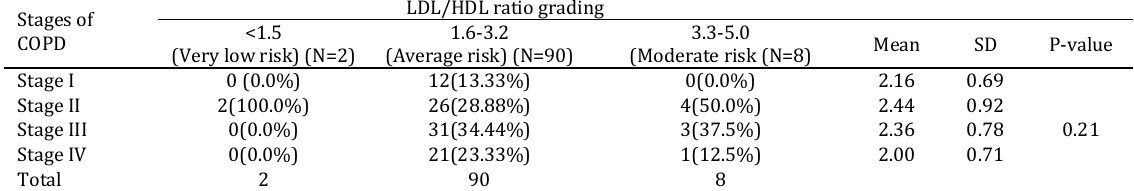
Table 6. Low-density lipoproteins/high-density lipoproteins ratio with chronic obstructive pulmonary disease stages Stages of